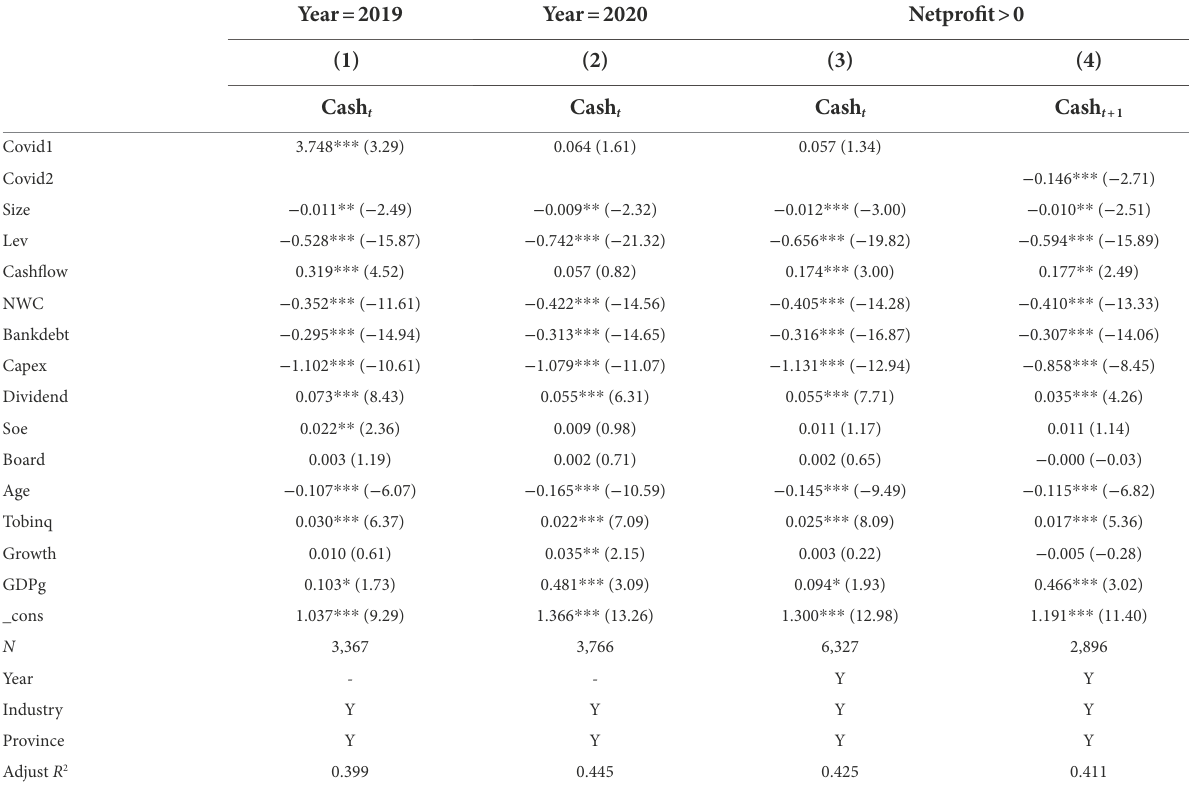
TABLE 6 COVID-19 impact and corporate cash holdings: independent analysis of the years and excluding loss-making